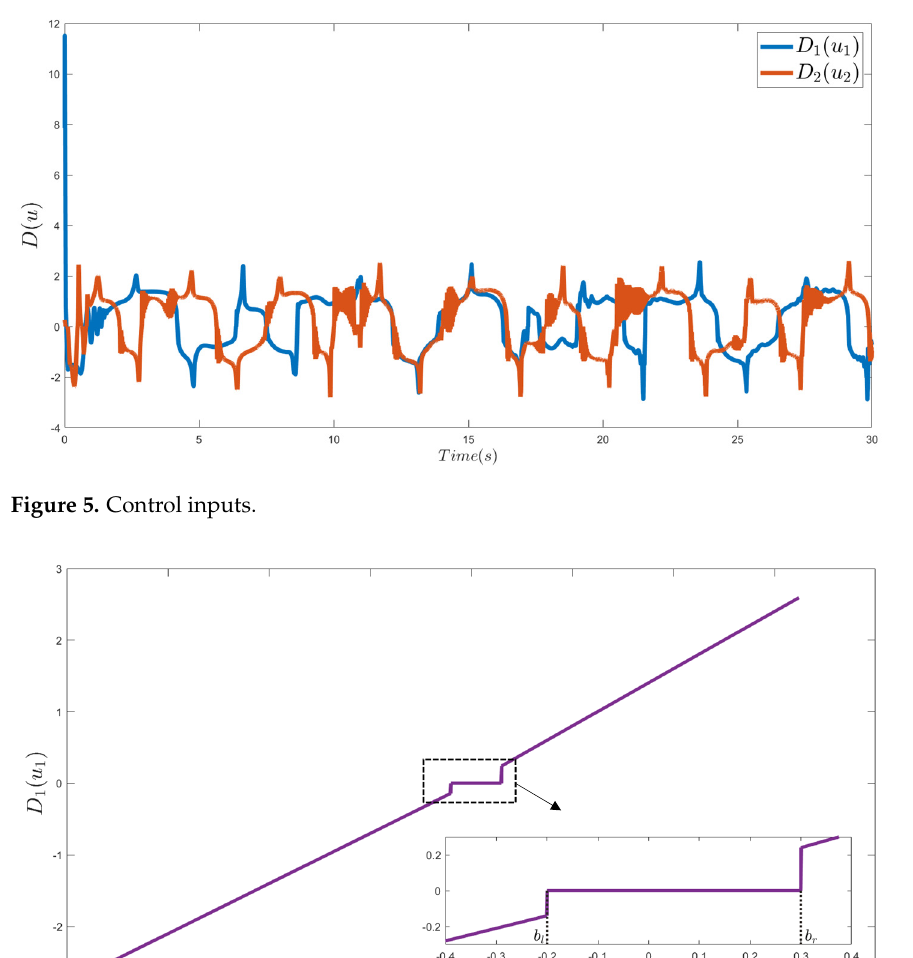
Figure 4. The output tracking result